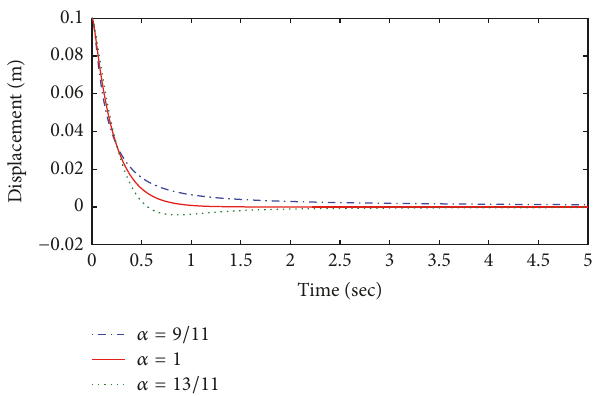
Figure 3: The curves of free damped motion of critical damping system with different